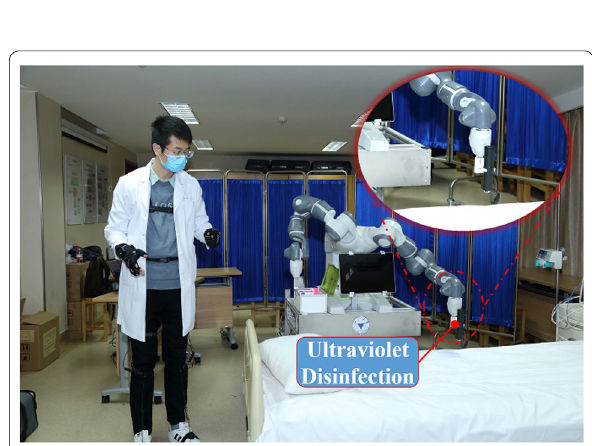
Figure 7 Remote extensive disinfection of the high-touch surfaces using the teleoperated